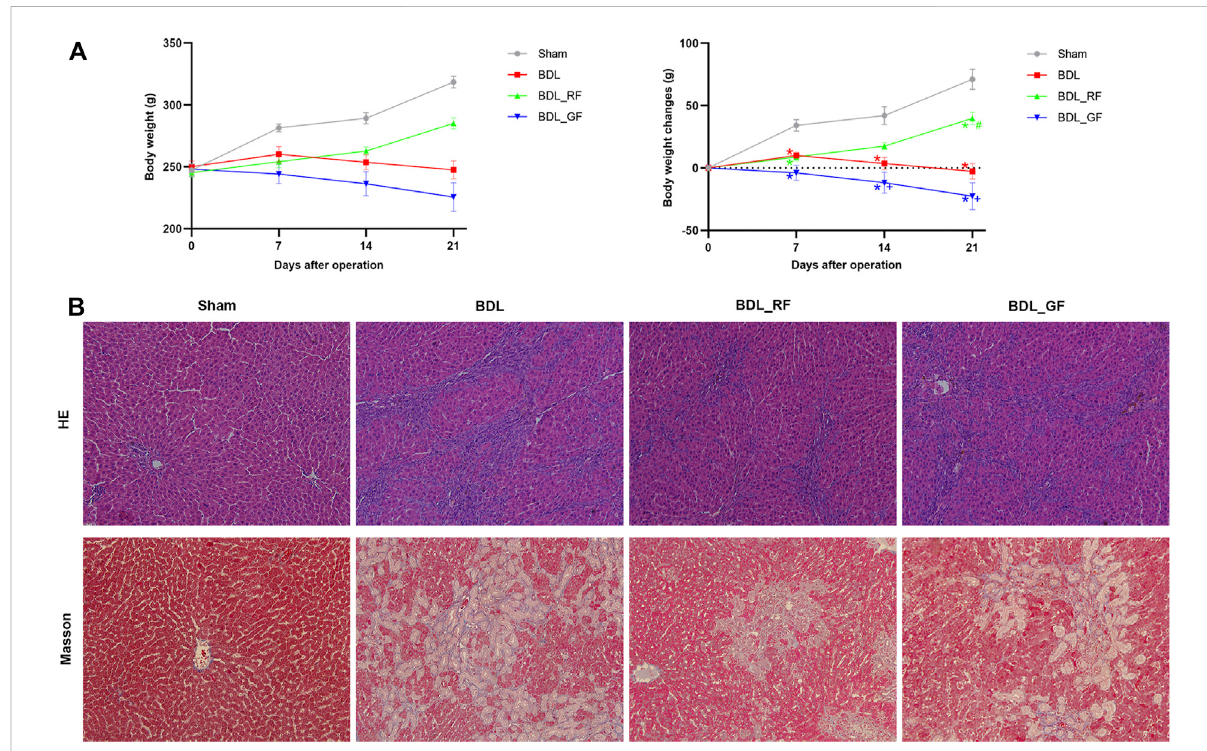
FIGURE 2 Effects of RF and GF on body weight and liver injury of BDL-rats. (A) Body weight changes; (*: p < 0.05, compared with the Sham group; #: p < 0.05, compared with the BDL group; +: p < 0.05, compared with the BDL_RF group, n = 6). (B) Representative histopathological fi ndings of